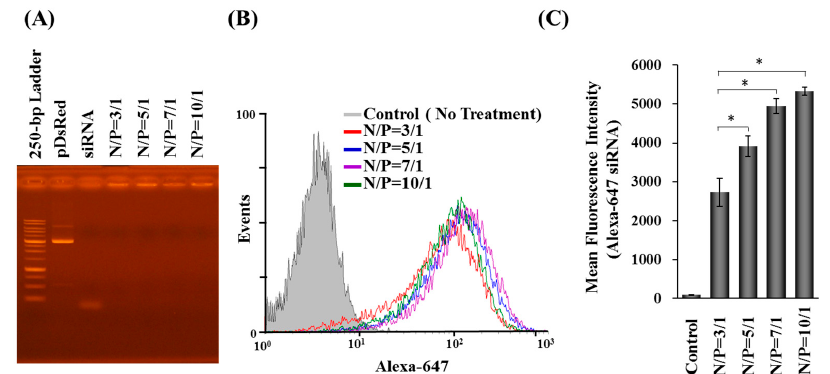
Figure 2. The binding capacity and cellular uptake of DDNPs. The nanoparticles were prepared by using different amount of PEI, plasmid and siRNA. The binding capacity between PEI and nucleic acid were analyzed by electrophoresis ( A ); The cellular uptake diagram ( B ) and fluorescent intensity ( C ) of nanoparticles composed of Alexa Fluor-647 labeled siRNA were examined by flow cytometry. * p < 0.05, significant difference between the group with various N/P ratio and the group with N/P ratio of 3/1 as analyzed by Student’s t